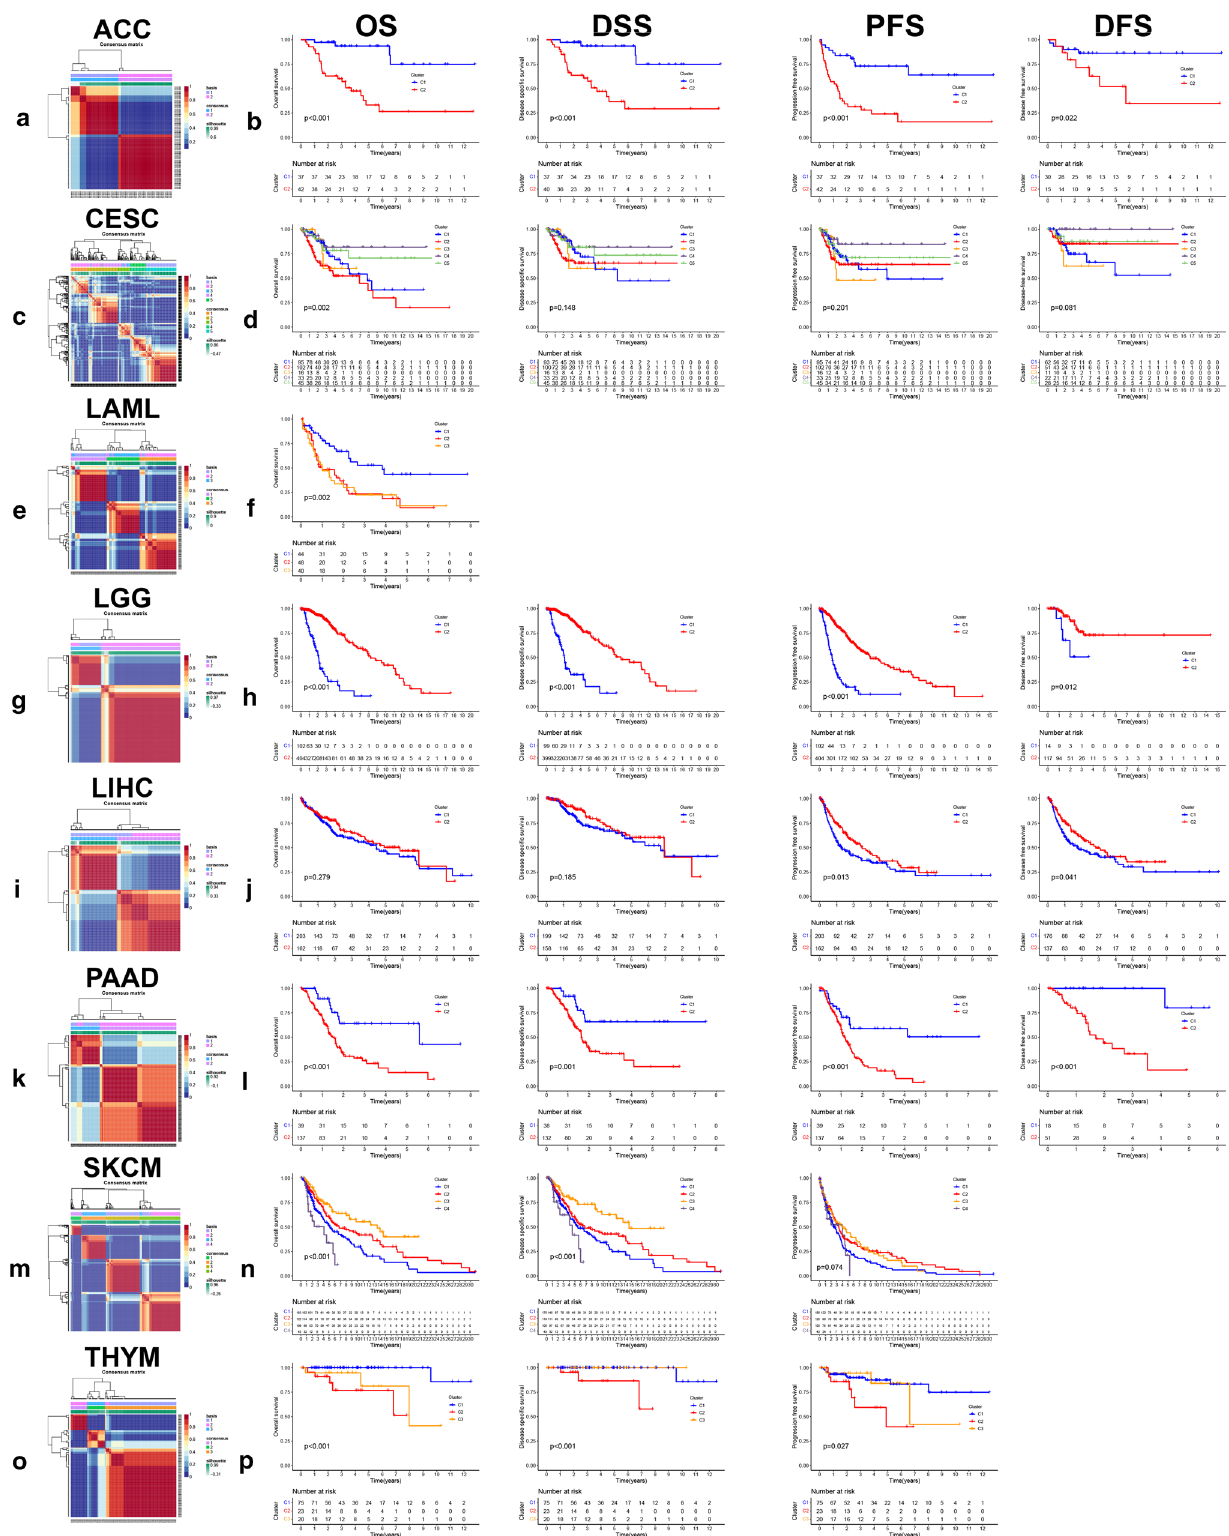
Fig. 3 Non-negative matrix factorization (NMF) classification based on prognostic DENGs. The NMF consensus matrix heat maps based on optimal K value showed the classification status of ACC ( a ), CESC ( c ), LAML ( e ), LGG ( g ), LIHC ( i ), PAAD ( k ), SKCM ( m ) and THYM ( o ). Kaplan– Meier plots ( b , d , f , h , j , l , n , p ) showed the relationship of different clusters and overall survival (OS), disease specific survival (DSS), progres- sion free survival (PFS) as well as disease free survival (DFS) in the eight cancers, with logrank p value marked in the